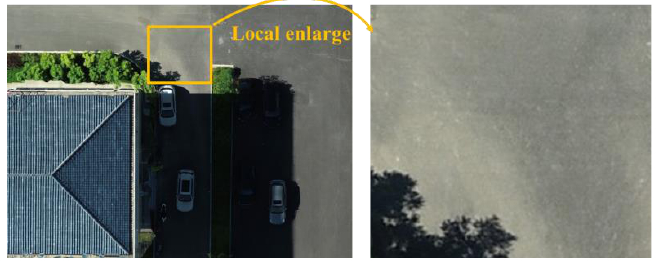
Figure 2. Example of different light intensity and reflectance of the same material.